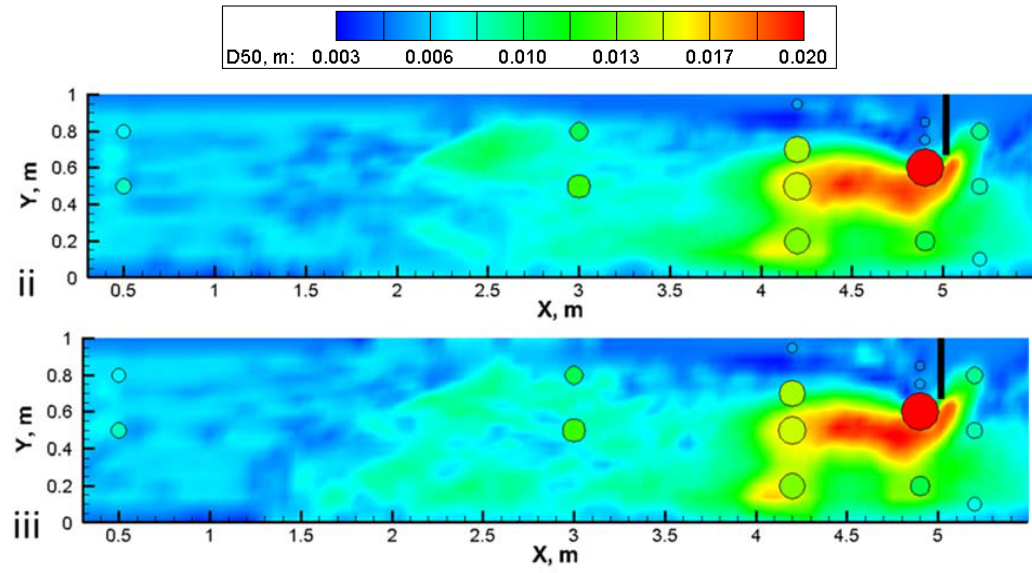
Figure 14. Measured (circles) and calculated (ii: Wilcock and Crowe formula; iii: combined approach) d 50 distribution at Q = 100 L/s.